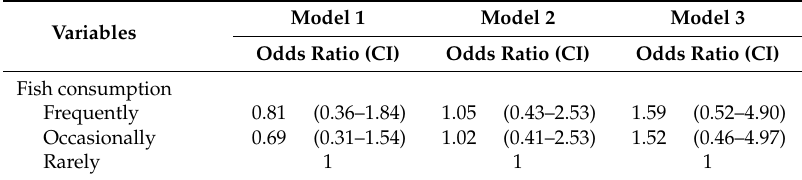
Table 6. Multiple logistic regression of fish consumption related to depressive symptoms in